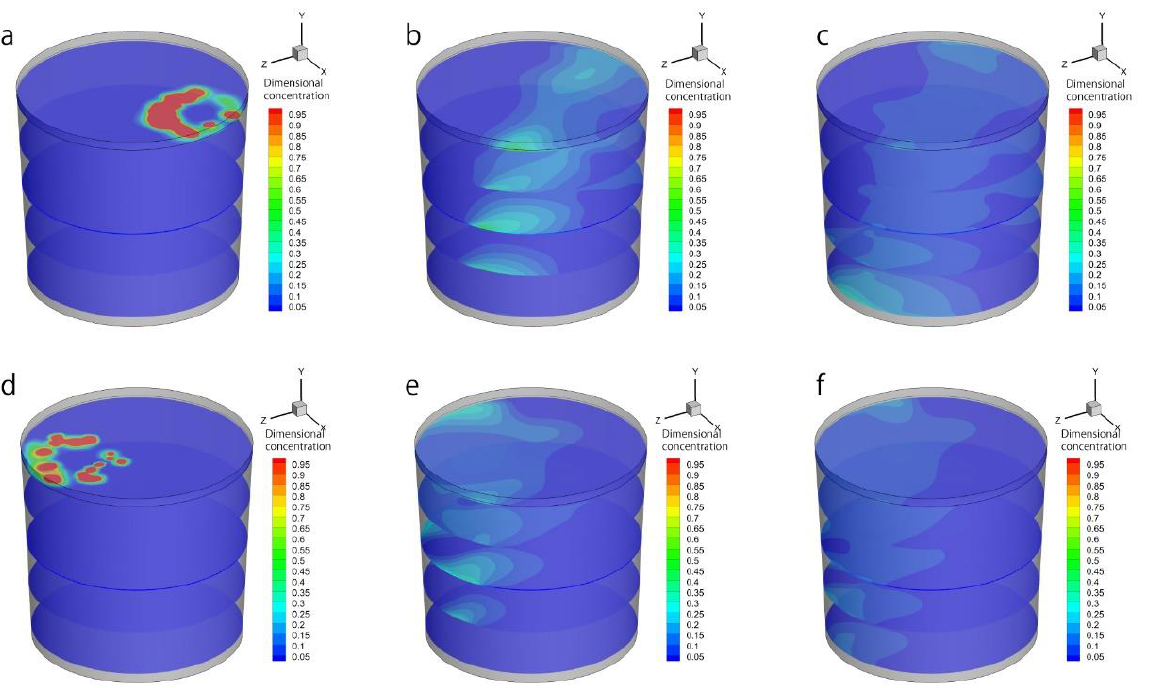
Figure 14. The contour of the slice of the dimensional concentration of the alloy species in the ladle when the alloy is added on the ‘slag eye’ above plug 1, after ( a ) 10 s, ( b ) 65 s, and ( c ) 120 s; when the alloy is added on the ‘slag eye’ above plug 2, after ( d ) 10 s, ( e ) 65 s, and ( f ) 120